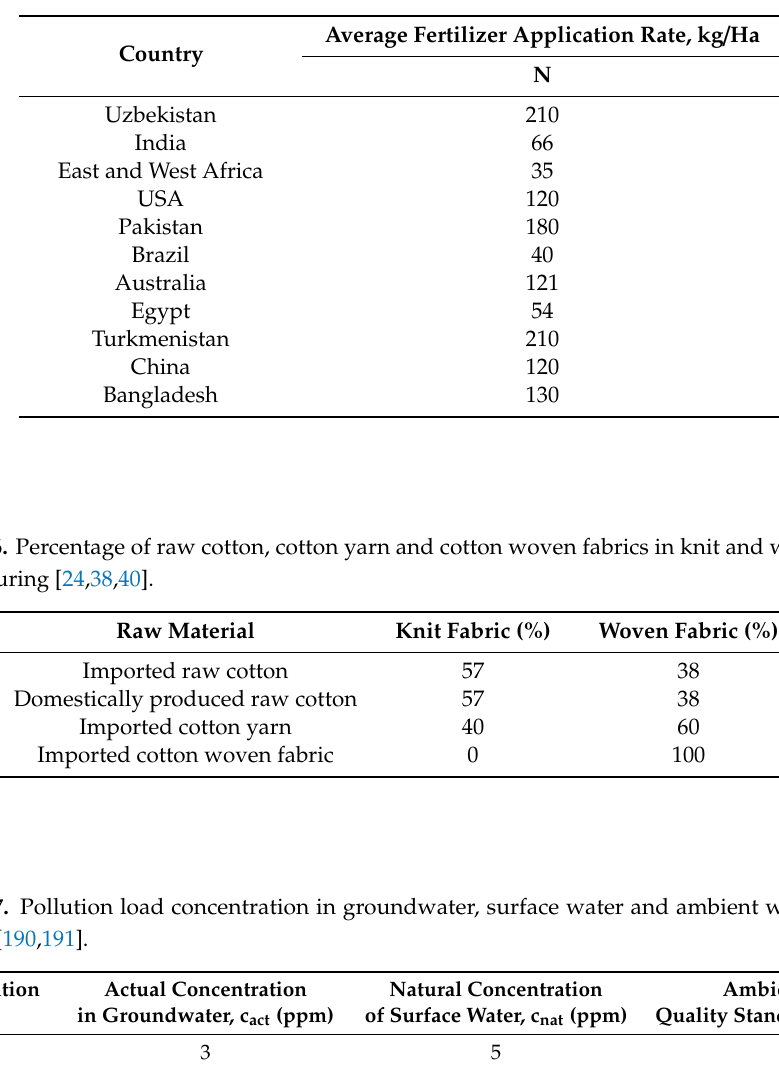
Table A15. Average fertilizer application for di ff erence countries [36,189].